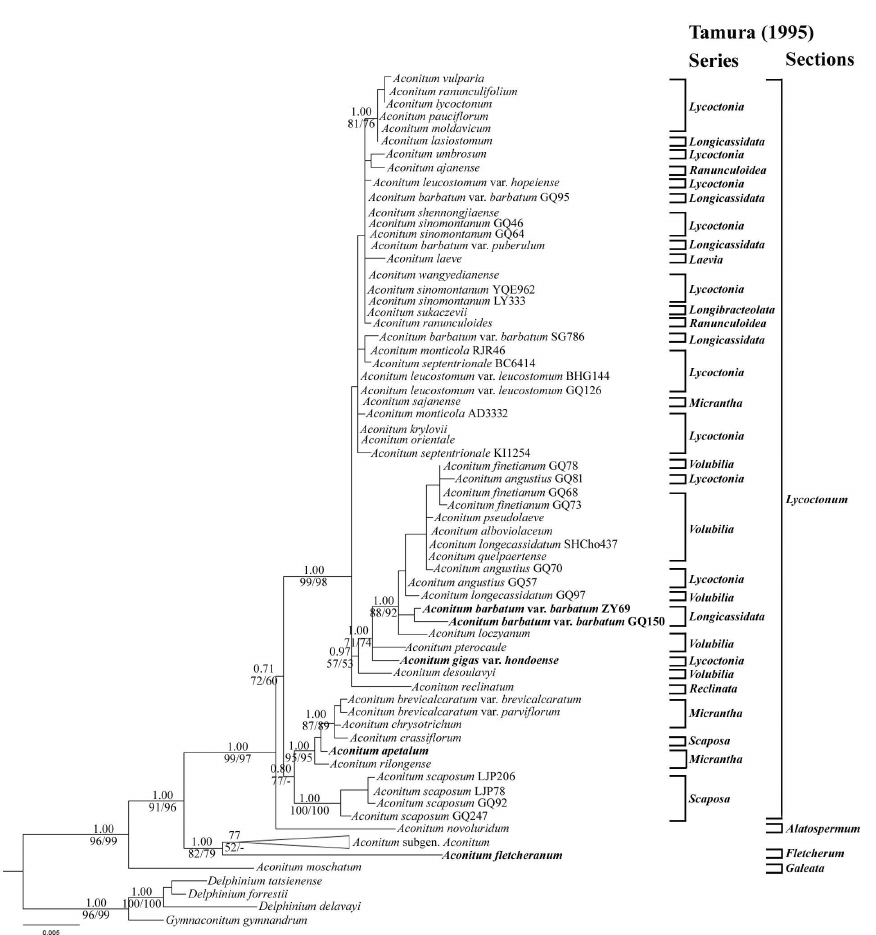
Fig 1. Phylogenetic relationships in Aconitum obtained from an ML analysis of the combined cpDNA dataset. Numbers above branches are posterior probabilities; numbers belowbranchesare bootstrap values for maximum parsimony/maximum likelihoodanalyses. “-” indicatesthat support is less than 50% bootstrap value. Tamura’s (1995) classification of subgen. Lycoctonum are shown on the right. Accessions with a different placementin the nrDNA tree are indicatedin bold. The clade of subgen. Aconitum has been collapsedfor saving space (see S1 Fig for the completetopology).